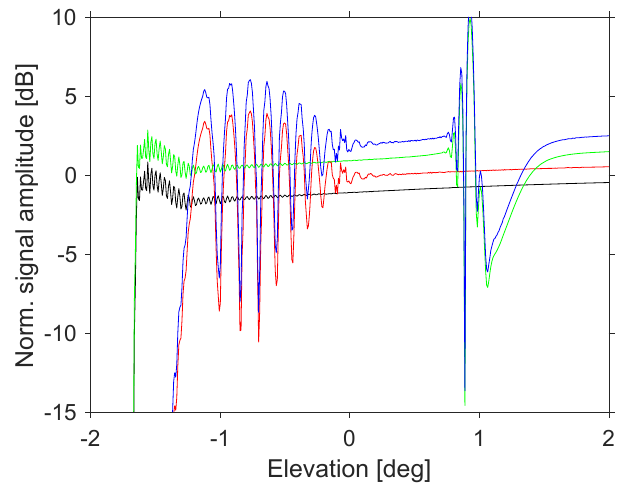
Figure 7. Normalised signal amplitudes as a function of elevation angle derived from several MPS simulations. Refractivities on the individual phase screens are calculated from an exponential profile furnished with a planetary boundary layer in the lower troposphere. Signal absorption at the surface is taken into account (red and blue lines); green and black lines show the result without ground ab- sorption. Two boundary layers are modelled: a horizontal boundary layer top at 2km altitude (red and black) and a layer top increasing from 1 to 2km between 30 and about 60km distance from the re- ceiver (blue and green). For legibility the red, green and blue lines are shifted by an additional +1, + 2 and + 3dB offset, respectively. For details see